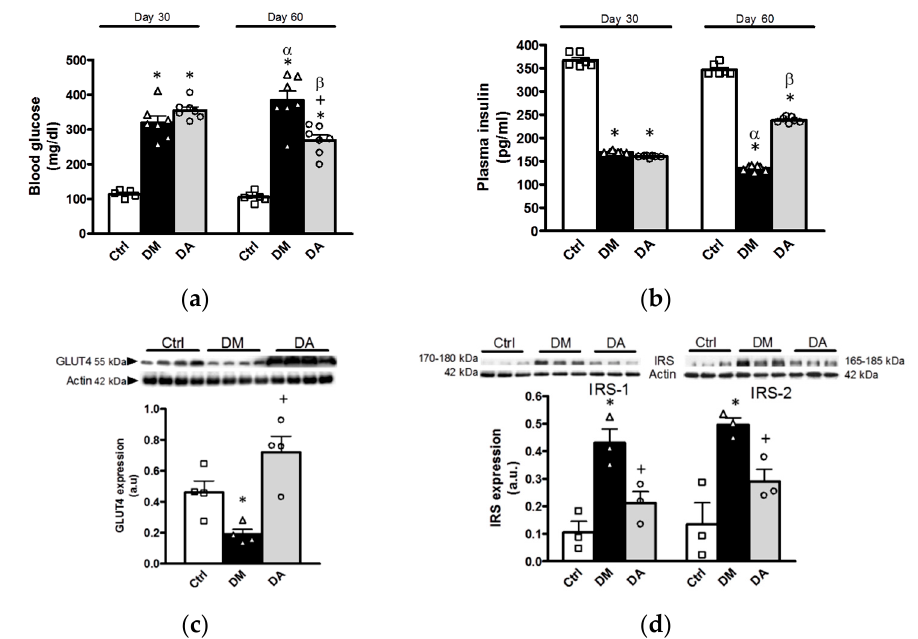
Figure 9. Effects of allicin on glucose homeostasis of rats. ( a ) Blood glucose and ( b ) plasma insulin levels; ( c ) glucose transporter expression and ( d ) insulin receptor substrate expression were assessed in skeletal muscle homogenate. Ctrl: control; DM: diabetic; DA: diabetic treated with allicin; a.u: arbitrary units. For representative Western blotting, 3 randomly selected samples per group were analyzed. Results are presented as mean ± SEM and analyzed by one-way ANOVA. Statistical significance was established as * p < 0.05 vs. Ctrl, + p < 0.05 vs. DM, α p < 0.05 vs. DM day 30, β p < 0.05 vs. DA day 30.